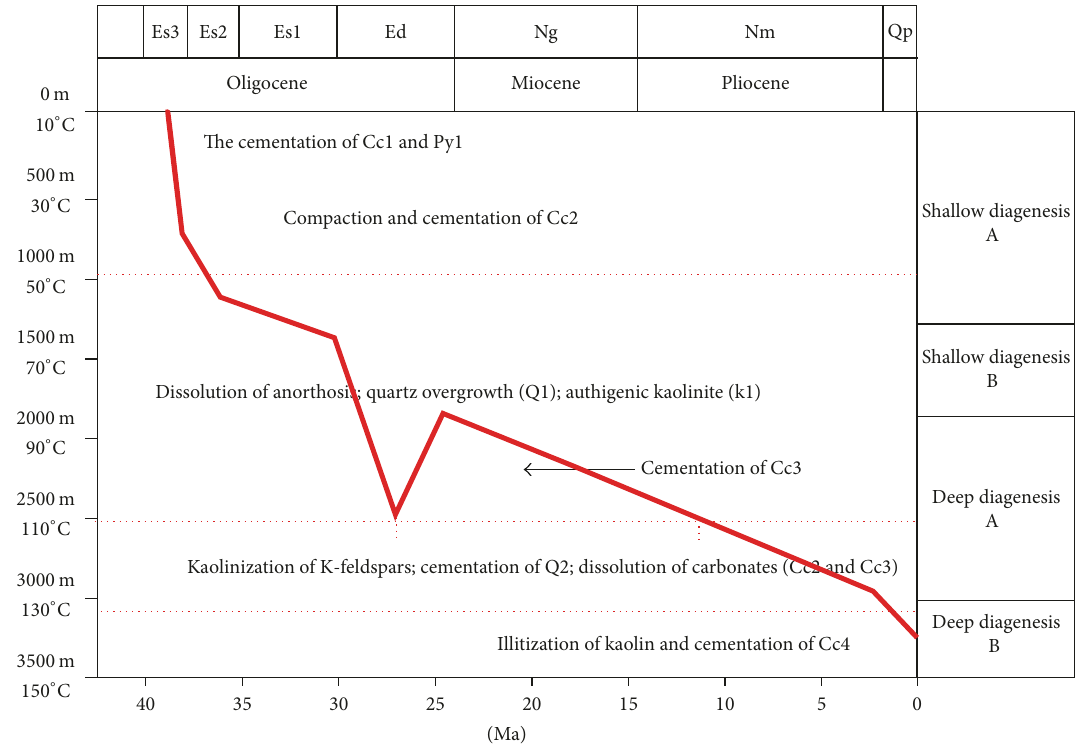
Figure 16: The diagenetic sequence of Es in Dongying Sag (paleogeothermal data was based on [50]; burial history was based on